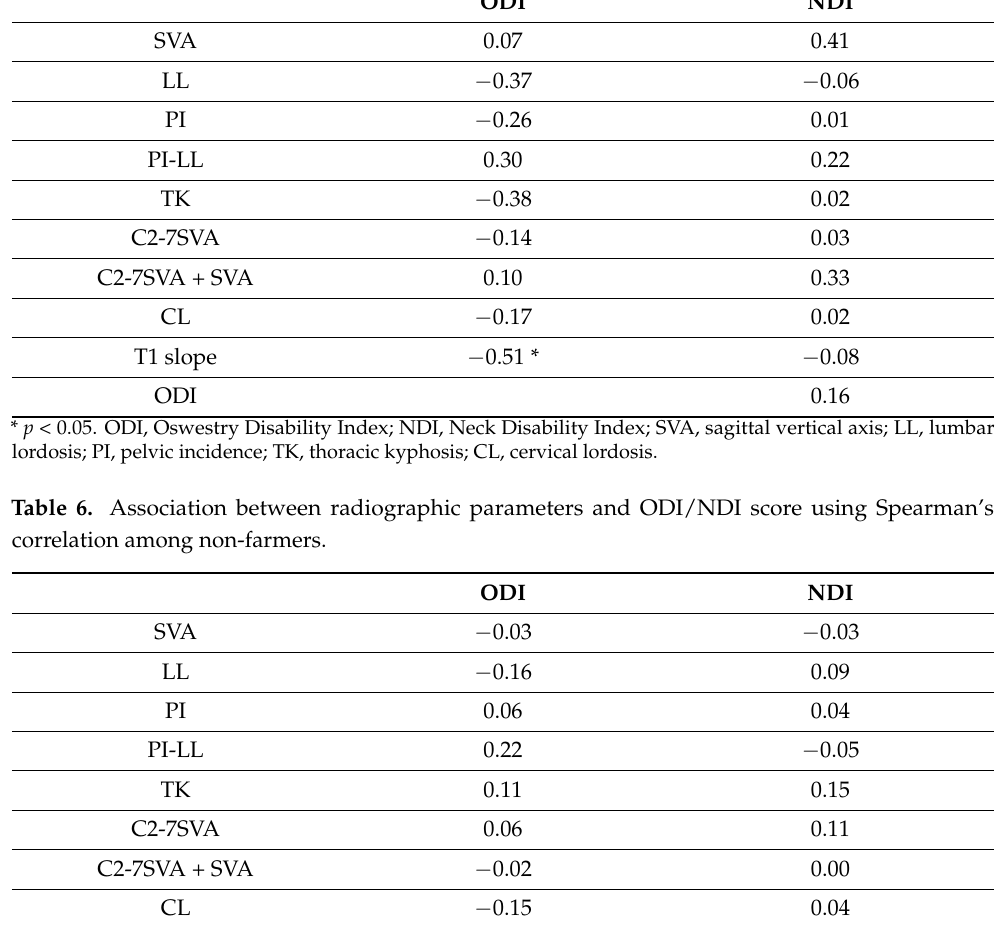
Table 5. Association between radiographic parameters and ODI/NDI score using Spearman’s correlation among farmers. ODI NDI SVA 0.07 0.41 LL − 0.37 − 0.06 − 0.26 0.01 0.30